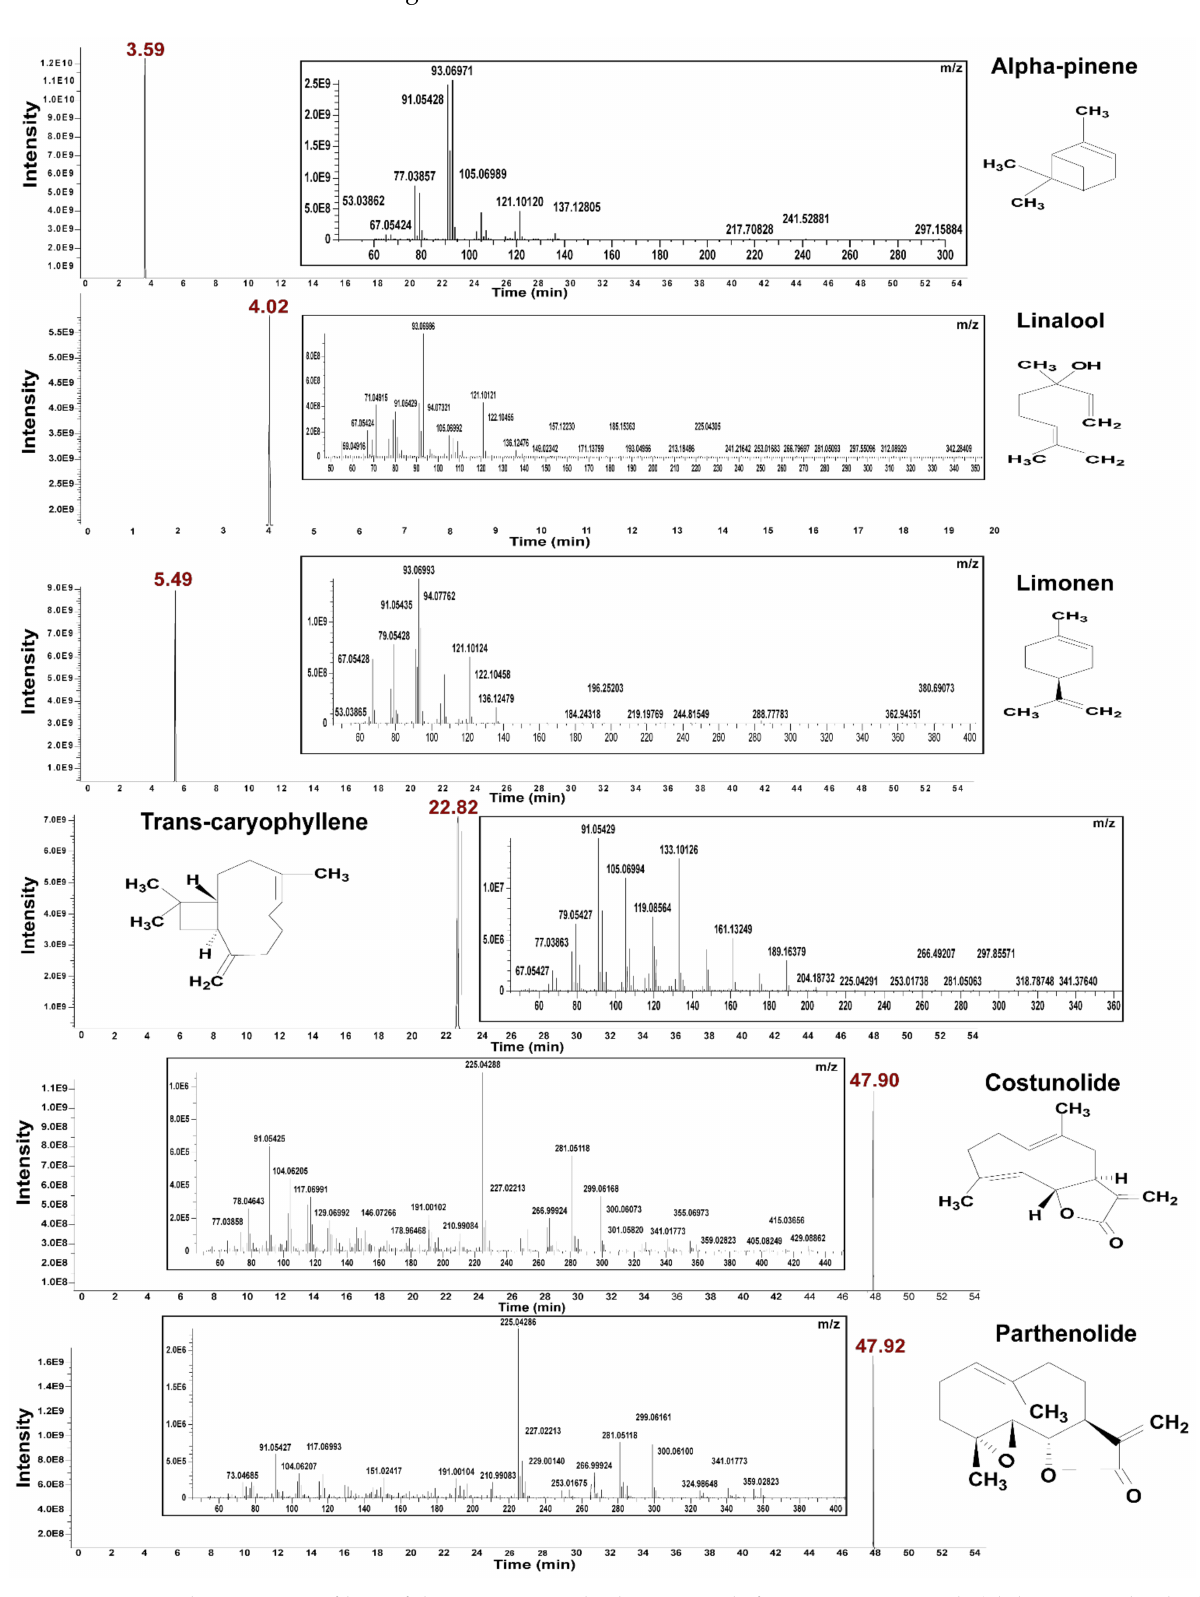
Figure 2. GC-Q-Orbitrap-MS profiling of three major standard compounds from monoterpenoids (alpha-pinene, linalool and limonene) and sesquiterpenoids (trans-caryophyllene, costunolide and